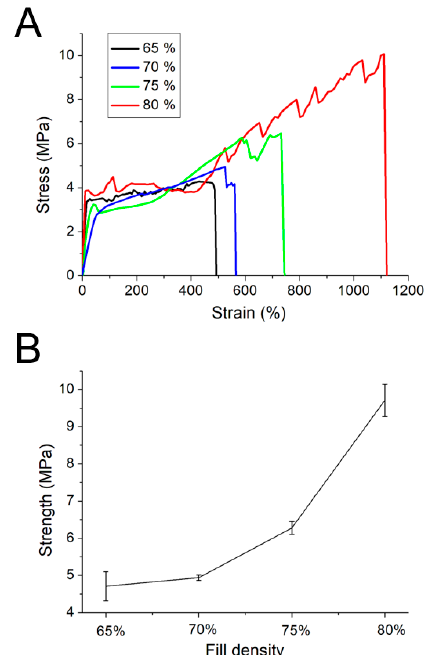
Figure 5. Effect of the PCL/DCM ratio on the mechanical properties of additively manufactured PCL parts (A: stress strain curves; B: maximum tensile strengths, other parameters used were those of Level 2 in Table 1).